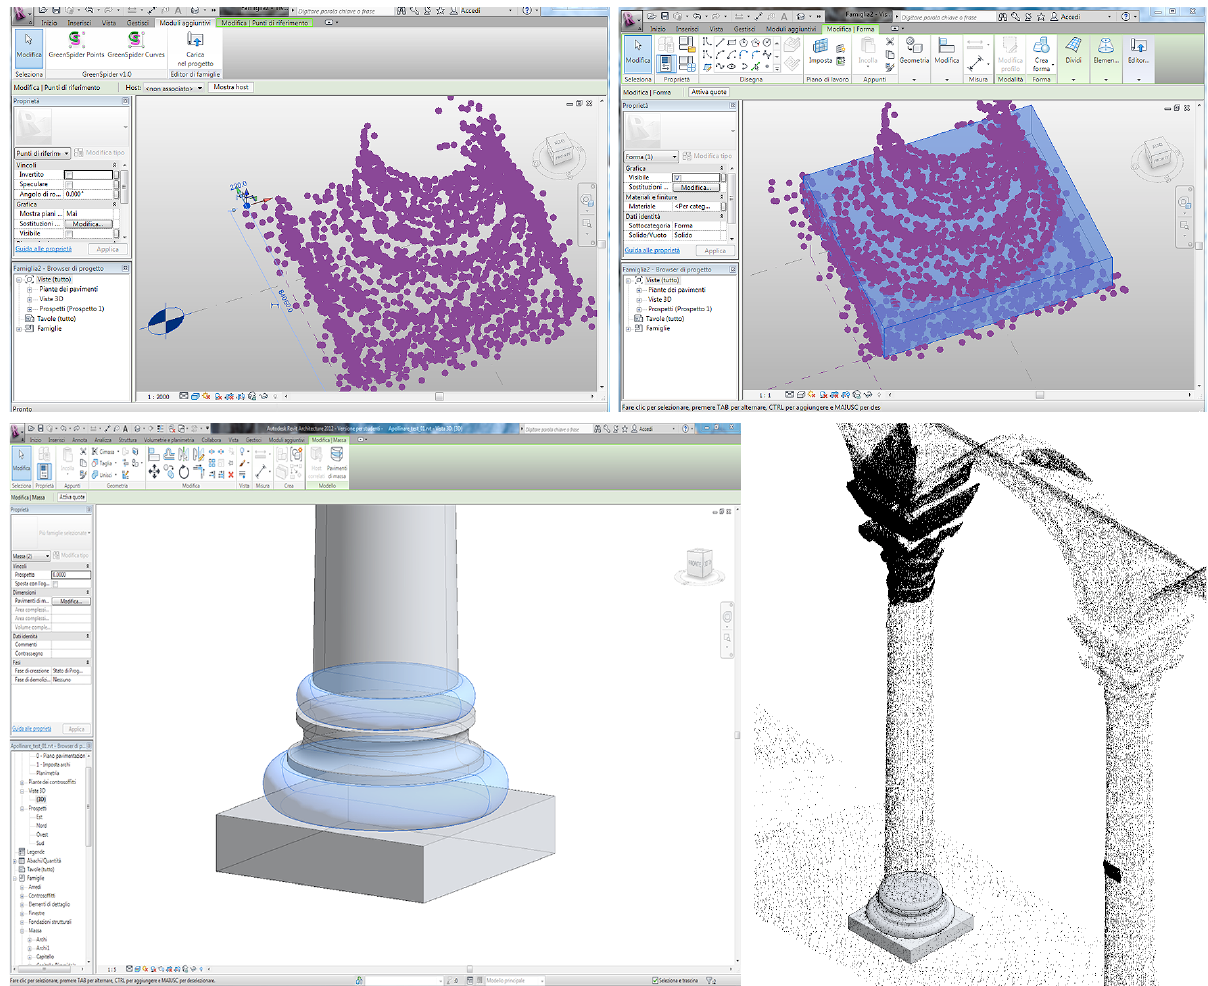
Figure 2. GreenSpider plug-in for Autodesk Revit 2012, developed by S. Garagnani in order to import selected vertexes from un- structured, relevant point clouds as native reference points. This way “ smart ” BIM elements can be traced out with accuracy obtaining parametric objects, which can be semantically